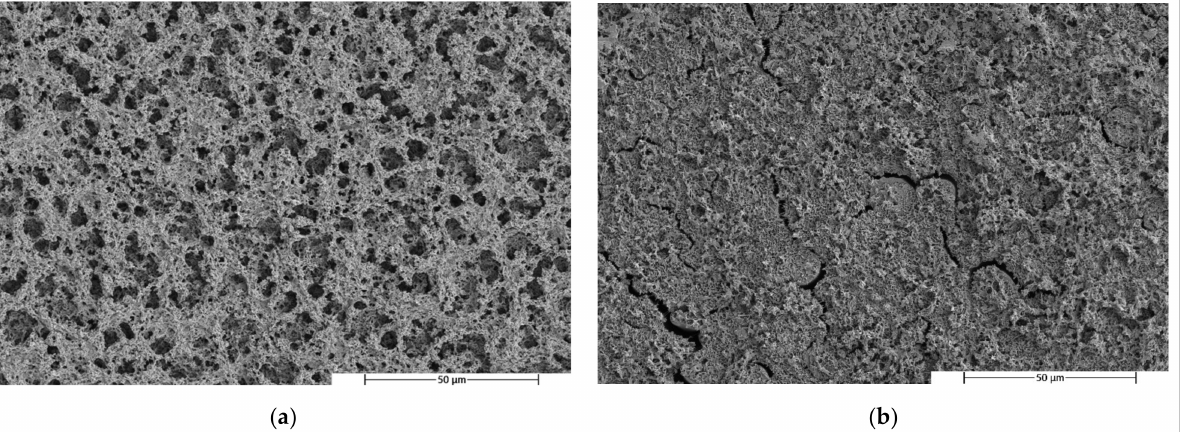
Figure 7. SEM micrographs of fractured surfaces after minor phase solving at 2500 × of ( a ) PLA80PBS20 and ( b ) PLA60PBS40